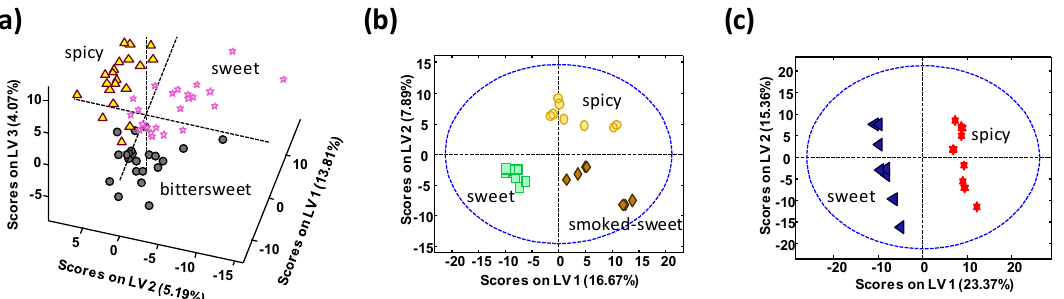
Figure 5. PLS-DA score plots when using UHPLC-HRMS metabolomics fingerprints as chemical descriptors for the classification of ( a ) La Vera PDO, ( b ) Murcia PDO, and ( c ) Czech Republic paprika samples according to their different taste varieties.